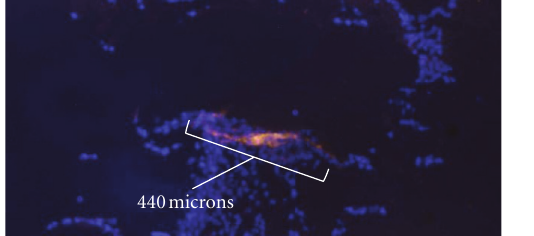
Figure 4: 40x magnification. Fluorescent image of osteoblast/endo- thelial cell cocultures—dapi stained nuclei (blue) and CD31 anti- body (bright orange) for endothelial cells. White bracket designates aggregate length measurement.